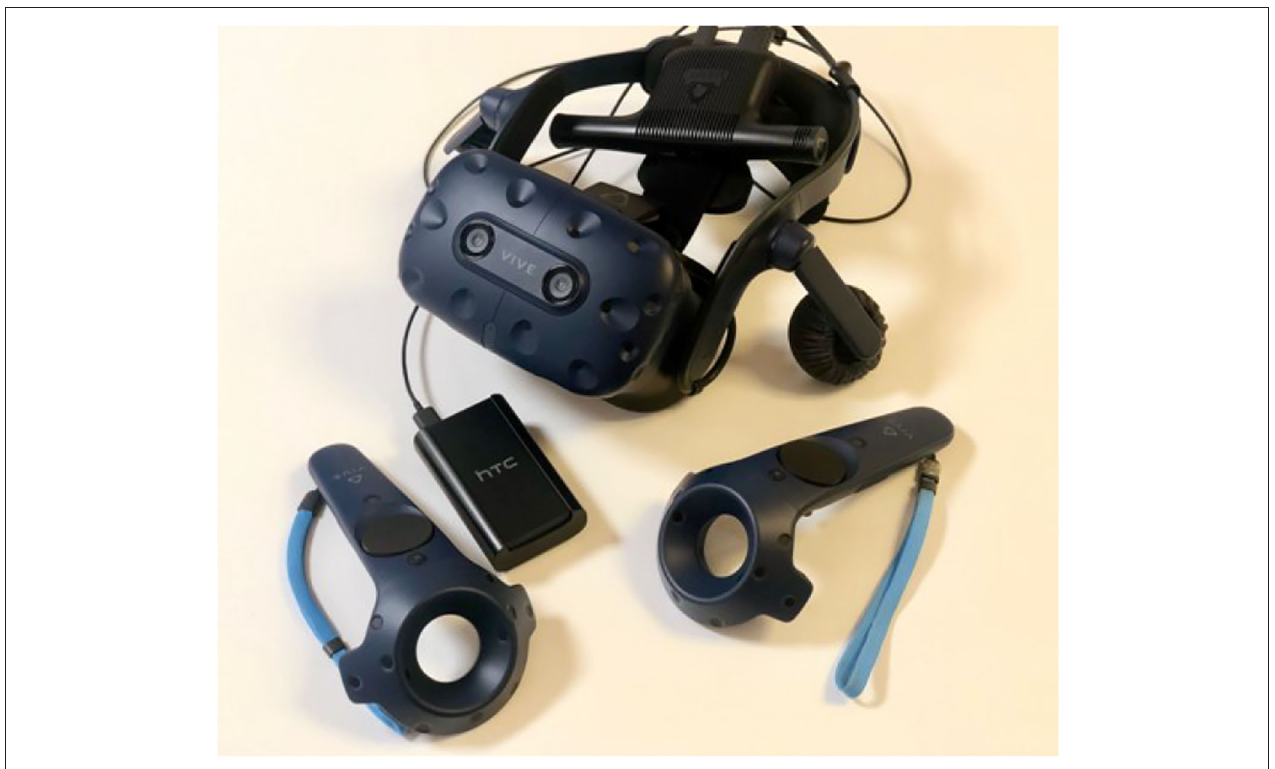
FIGURE 9 | HTC Vive